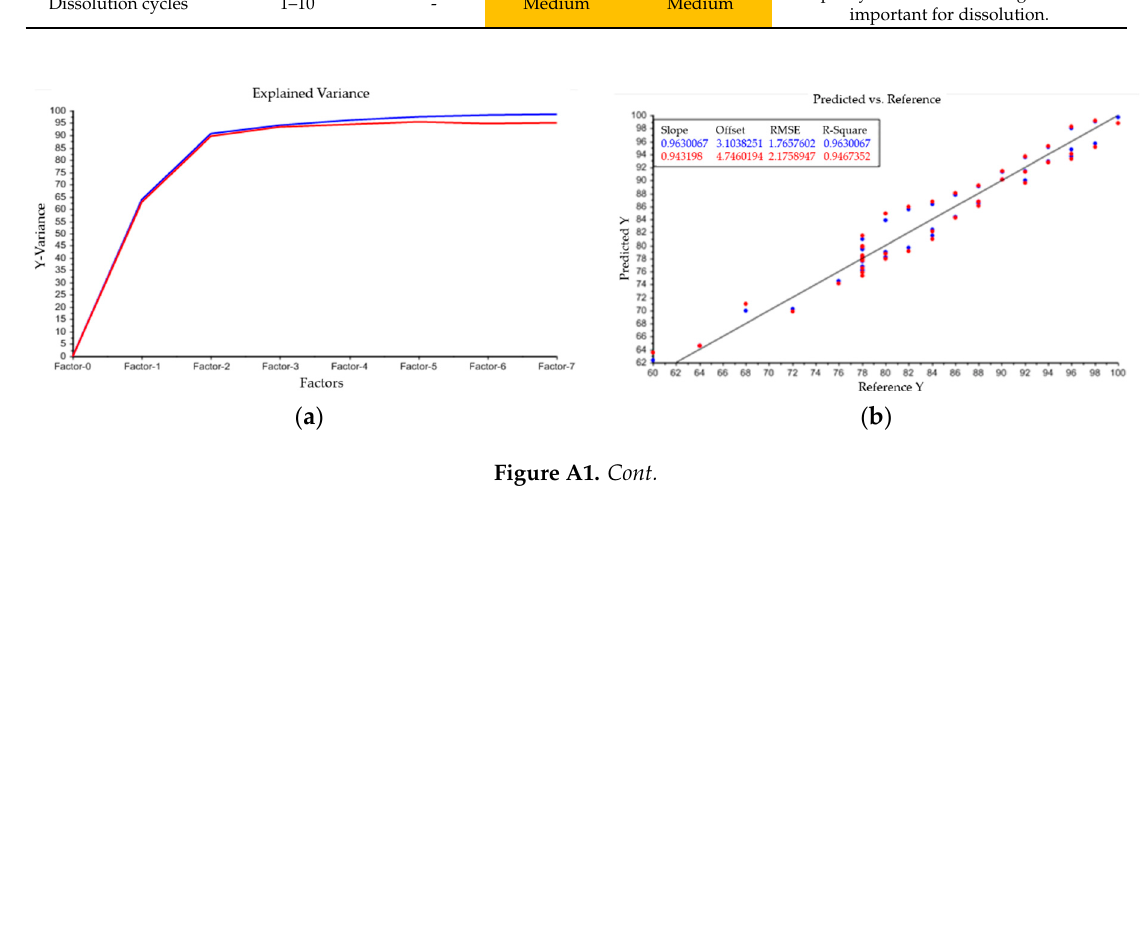
Figure A1. Model output: ( a ) describes the relation between principle components and variance of spectral data. Plots ( b–d ) indicate the model accuracy of predicted vs. reference data for the three investigated components water ( b ), PEG 4000 ( c ) and PEG 400 ( d